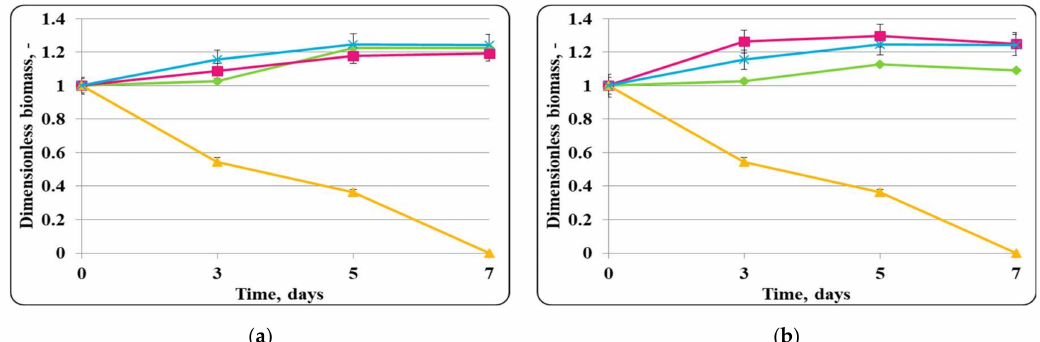
Figure 5. ( a ) free lactobacilli cells; ( b ) encapsulated lactobacilli cells. Changes in the population of viable cells of Lb. helveticus 2/20 and E. coli ATCC 25922 in MRS broth at 20 ± 2 ◦ C. Legend: Green (cid:117) : Lb. helveticus 2/20 population following its inoculation; Pink (cid:4) : Lb. helveticus 2/20 population following its co-inoculation with E. coli ATCC 25922; Blue × : E. coli ATCC 25922 population following its direct inoculation; Yellow (cid:78) : E. coli ATCC 25922 population following its co-inoculation with Lb. helveticus